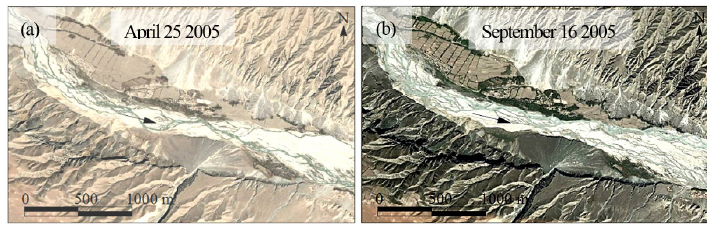
Figure 10. Braided channel evolution of the middle Daheba River in 2005 (a) in non-flood season, (b) in flood season.